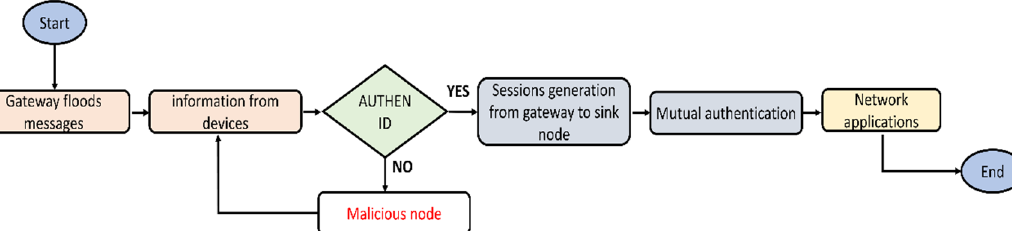
Figure 4. Flowchart of the proposed algorithm.